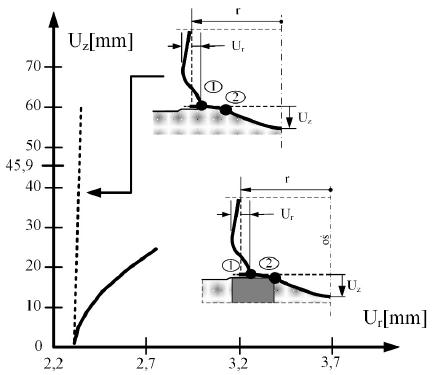
of tank bottom z at the point No. 2 for type A and r (Fig. 4, Fig. z